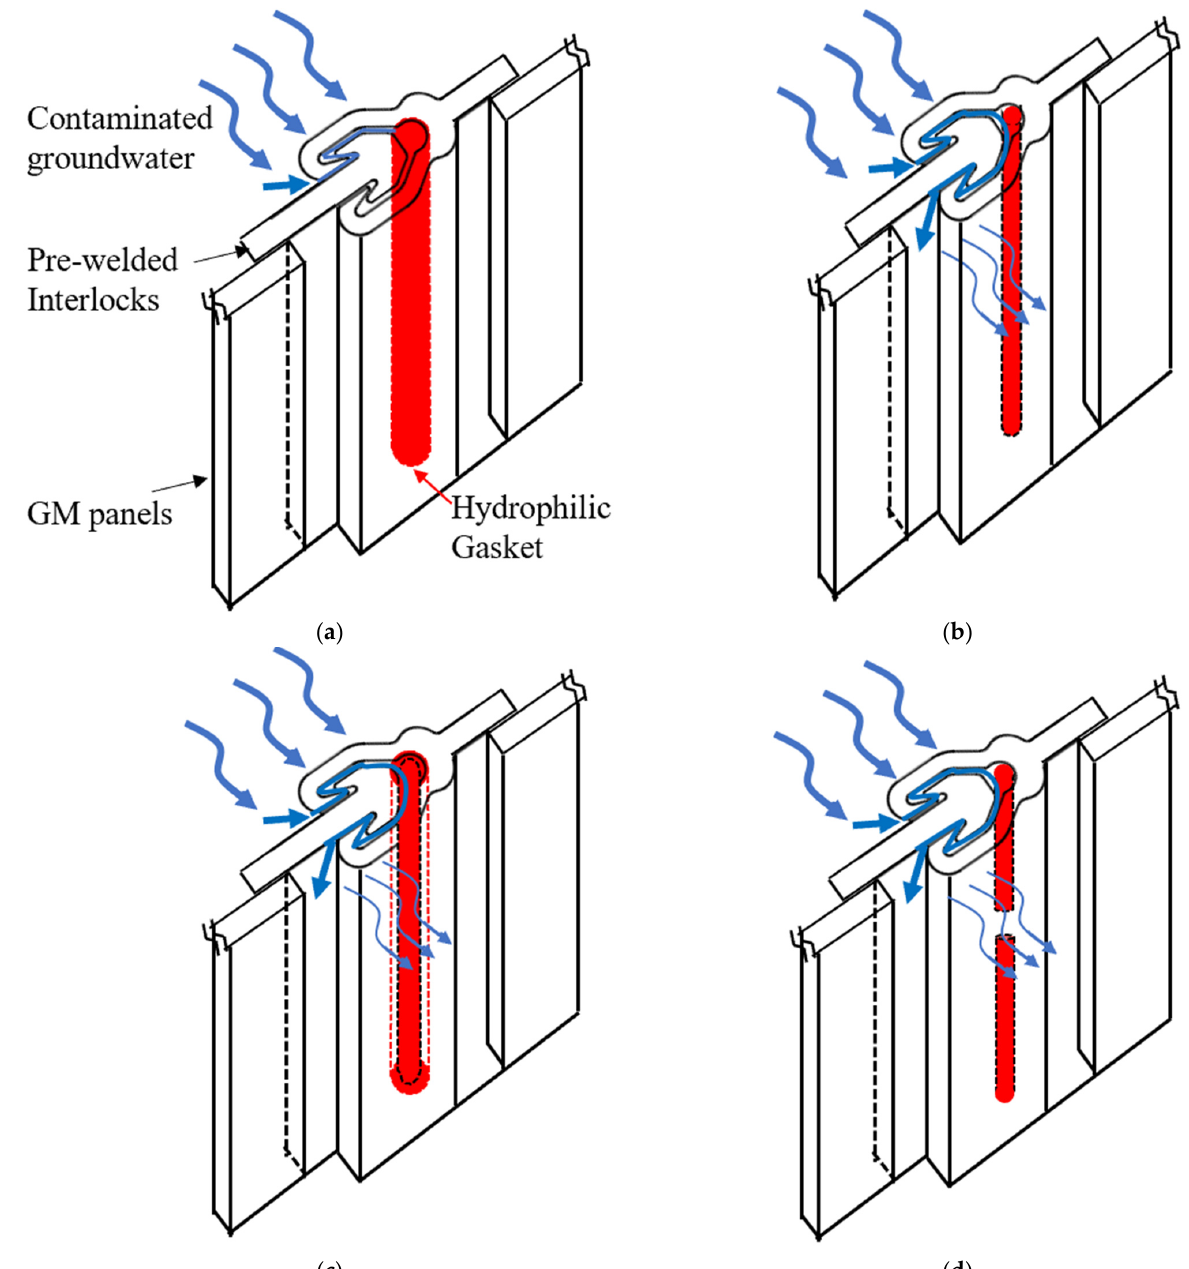
Figure 1. Schematics of the effect of contaminants on swelling ratio and leakage of the hydrophilic gaskets: ( a ) the high swelling ratio of the gasket with an intact seal, ( b ) the low swelling ratio of the gasket, ( c ) the high swelling ratio of the gasket with expansion-relaxation, and ( d ) defective Hydrophilic gasket with fracture.